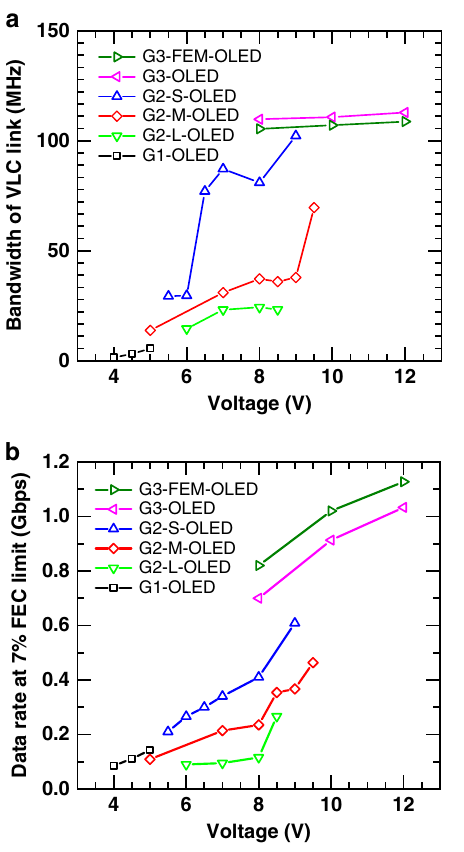
Fig. 2 Communication performance of the OLED devices in a VLC link. a Bandwidth of the VLC link, and b data rate at 7% FEC limit for each type of OLED.